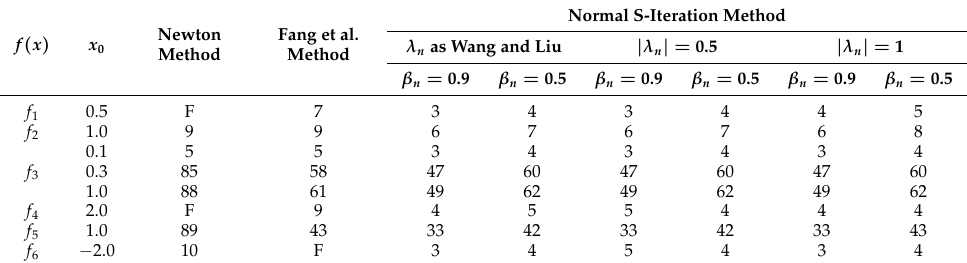
Table 2. Functions for which third-order differential does not exist.